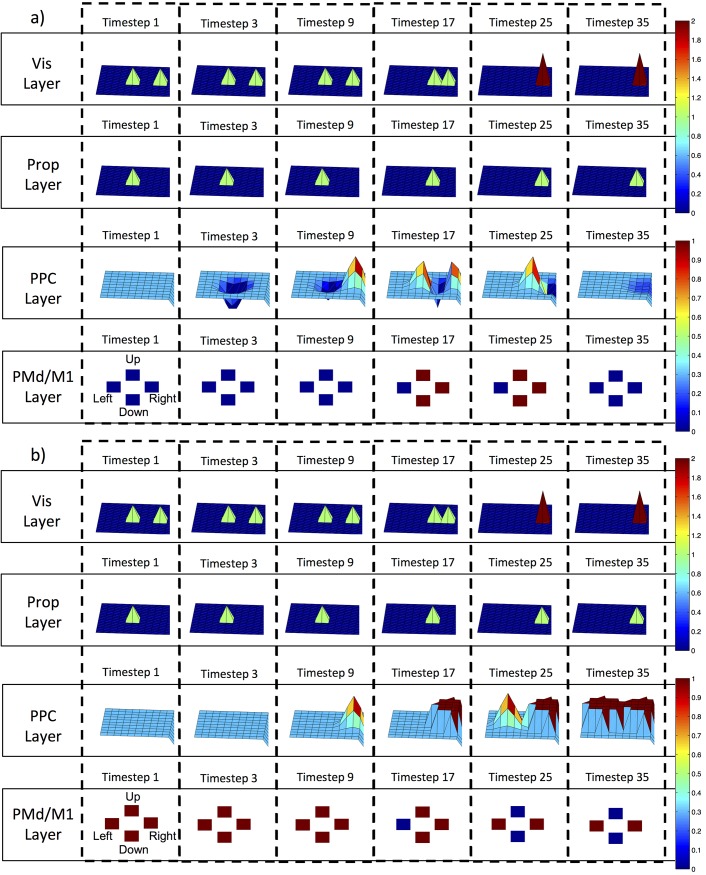
Different strategies taken by the Feedforward and Lateral Models.The colors and corresponding colorbars (right) depict qualitative descriptions of neural activity in the model during a rightward reaching trial in the VG task. The surface plots were derived from the neural activity of the different models and are supplement to the data shown in Fig 6. The Vis Layer (first row) represents the visual input firing rates projected onto the PPC neurons for the corresponding timesteps (columns). The Prop Layer (second row) represents the proprioceptive input firing rates projected onto the PPC neurons. The PPC Layer (third row) represents the PPC neural firing rates that resulted from the sensory inputs with their corresponding delays, and shows how the sensory information was combined during a correct reach to a rightward target. The PMd/M1 Layer shows the four directionally encoded (Up, Down, Left, and Right) PMd/M1 neurons and the respective firing rates for the labeled timesteps. a) Schematic of neural activity for the FF model. The visual input from the Vis Layer at Timestep 1 is reflected in the PPC neural firing rates at Timestep 9. Similarly, the proprioceptive input from the Prop Layer is reflected in the PPC neural firing rates at Timestep 3. The network generated changes in hand position by exciting the PMd/M1 Right neuron. The hand position did not change in the vertical plane (up and down) because both the PMd/M1 Up and Down neurons fired at the same rate. b) Schematic of neural activity for the LAT model. Unlike the FF model, the PPC neurons compensated for the proprioceptive input, which resulted in no change in firing rate across the PPC Layer at Timestep 3. Similarly, the visual representation of the hand location was suppressed as a result of the intrinsic lateral connectivity, which is indicated by the absence of a second bump of activity (small pool of neurons) across the PPC neurons at Timestep 9. The PPC neural activity representing the target location was saturated at Timestep 17, indicated by the dark red hue across a small set of PPC neurons. Changes in the hand position were generated through the suppression of the Left PMd/M1 neuron’s activity while the other three neurons’ firing rates remained saturated. The stopping behavior was generated by the second bump (small pool) of activity across the PPC neurons at Timestep 25, which resulted in a reactivated Left PMd/M1 neuron and complete suppression of both the Up and Down PMd/M1 neurons.